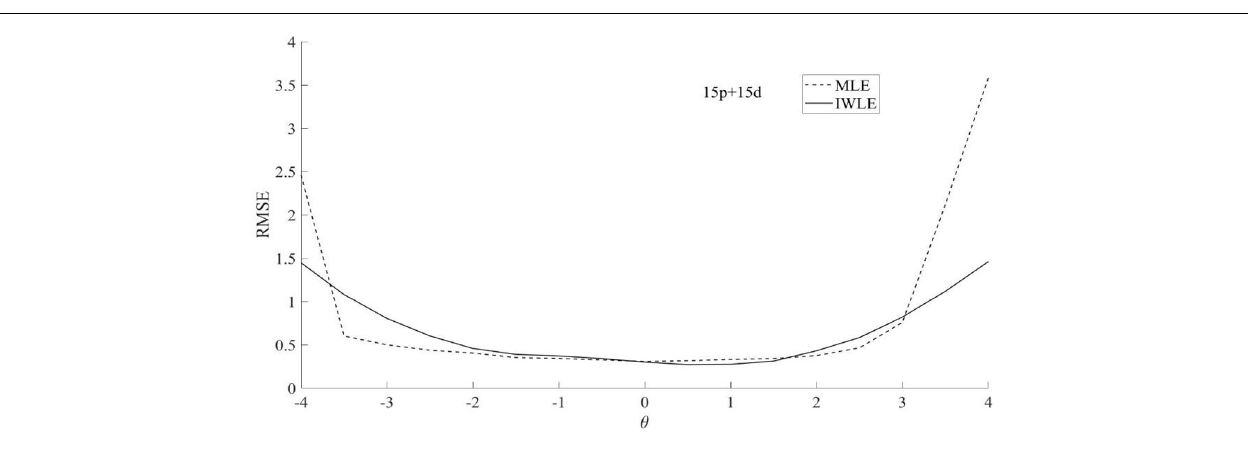
Frontiers in Psychology |